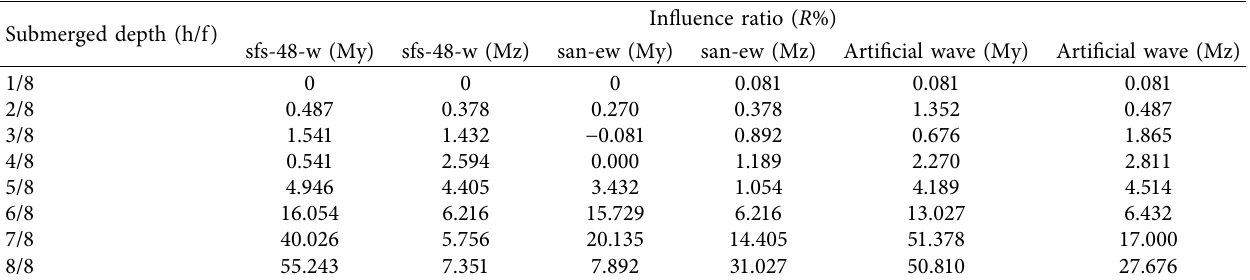
Table 3: Te relation of R and submerged depth at L/16 of the